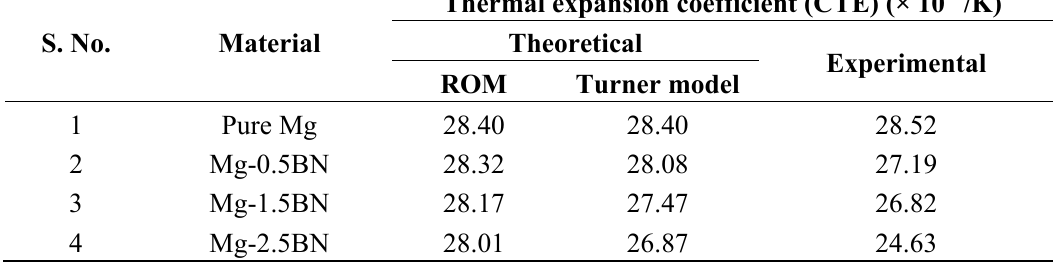
Table 3. Results of coefficient of thermal expansion (CTE) measurements. ROM, rule of